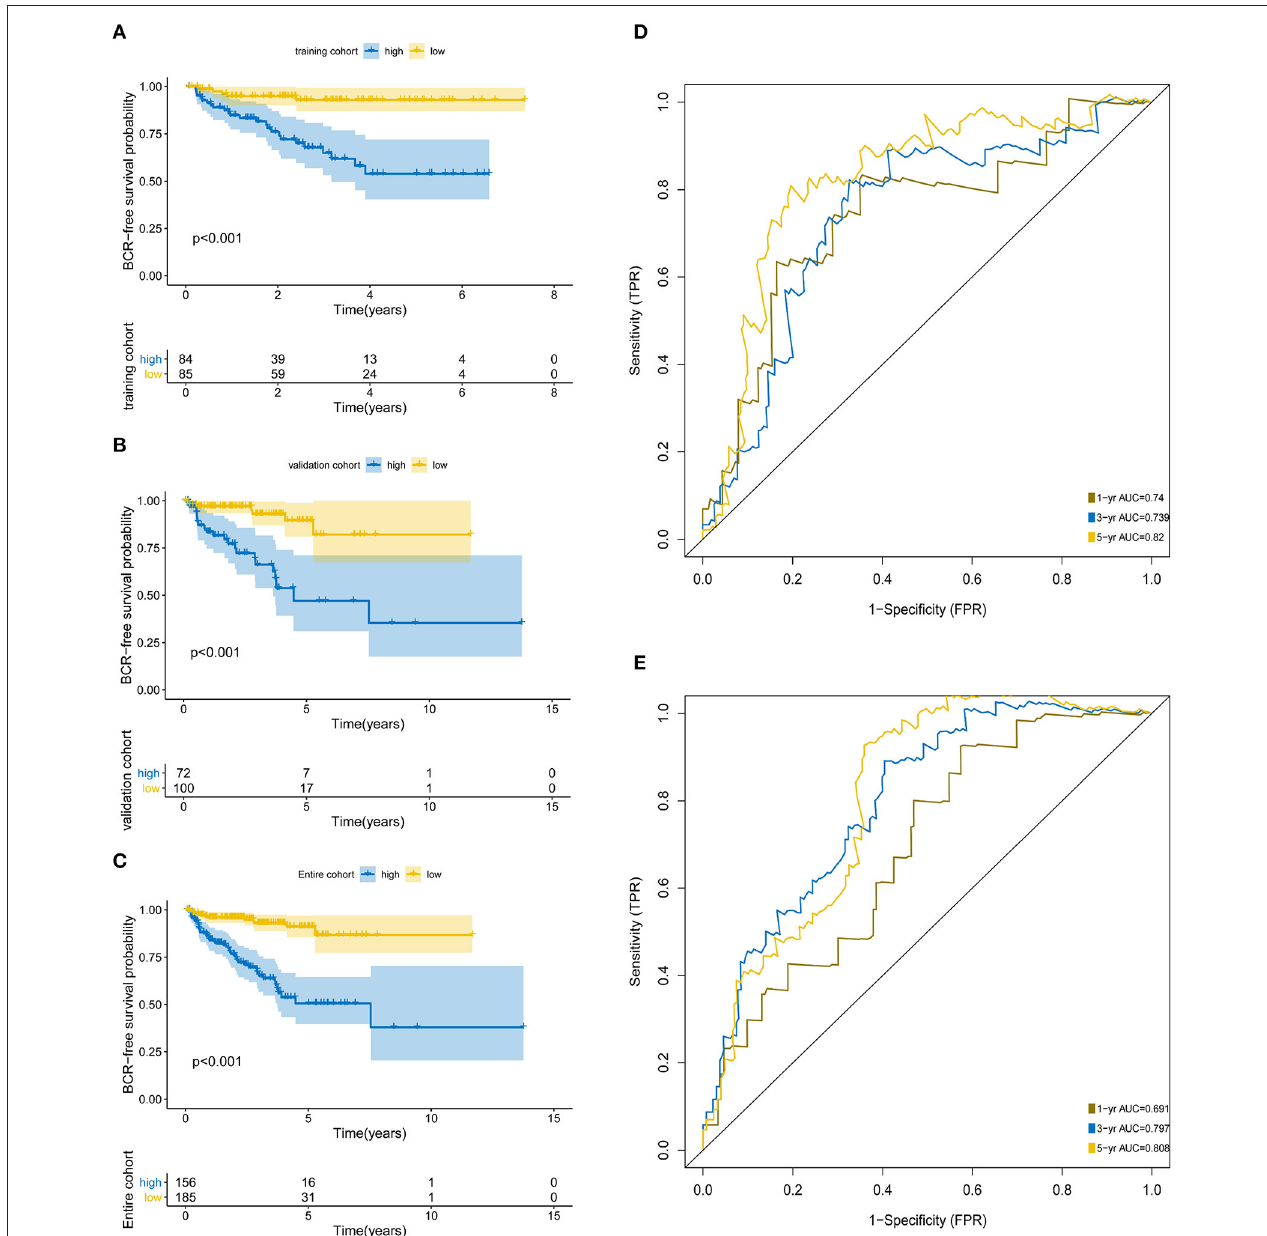
FIGURE 3 | Kaplan-Meier survival analysis and ROC curves according to the prognostic signature. Kaplan–Meier curves for (A) the training group ( N = 172); (B) the test group ( N = 169); (C) the entire group ( N = 341). ROC curves at 1, 3, 5 years for (D) training group, (E) test group.